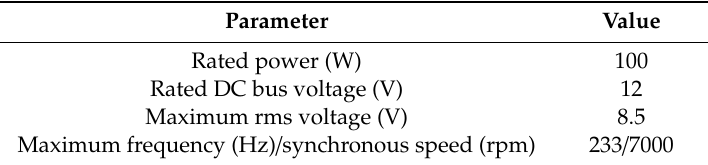
Table 1. Imposed data in the design procedure of the induction machines (IMs).